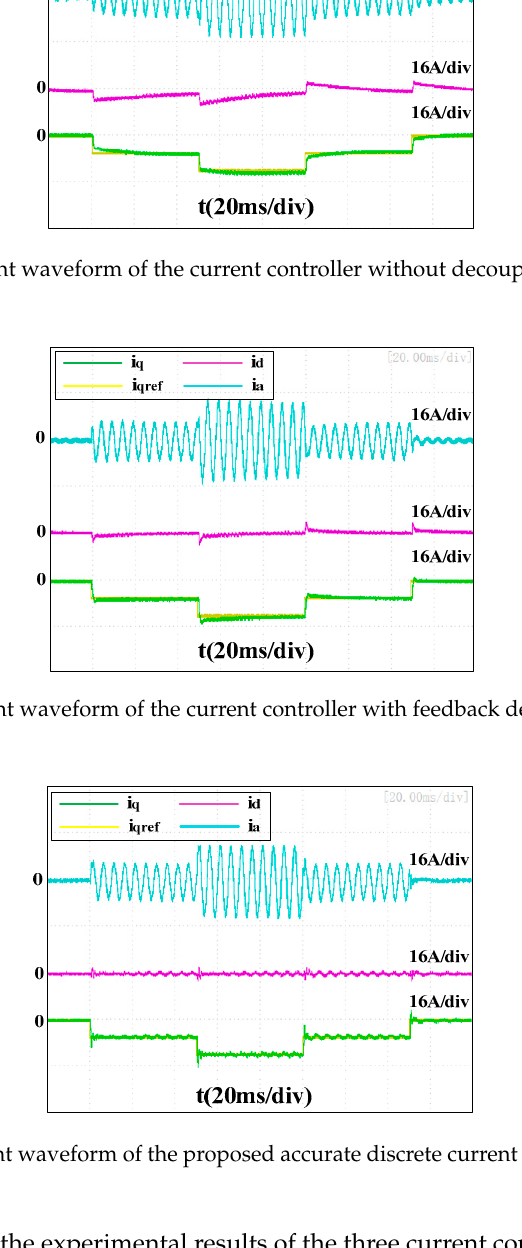
Figure 23. d-q axis current waveform of the proposed accurate discrete current controller at 12,000 rpm with Kdq = 500 π Ls , ˆ 0.8 s s L L = .